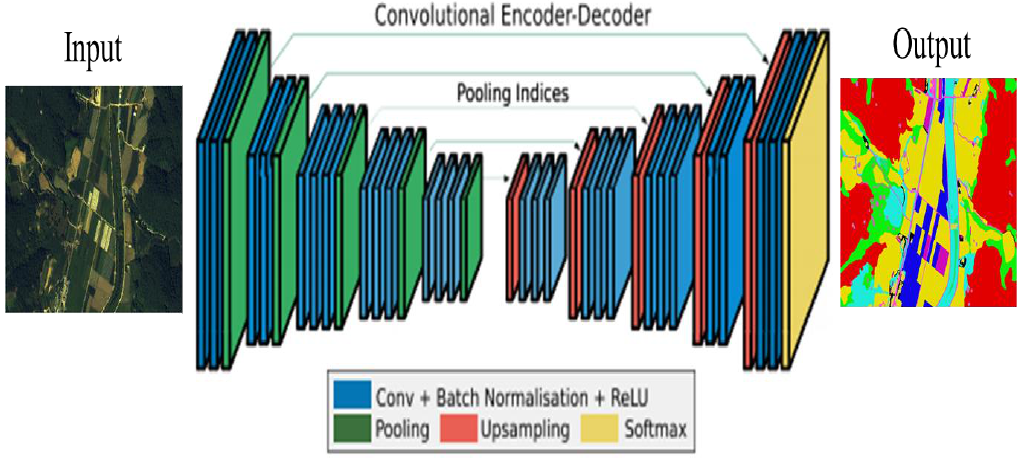
Figure 2. SegNet architecture introduced in [41].